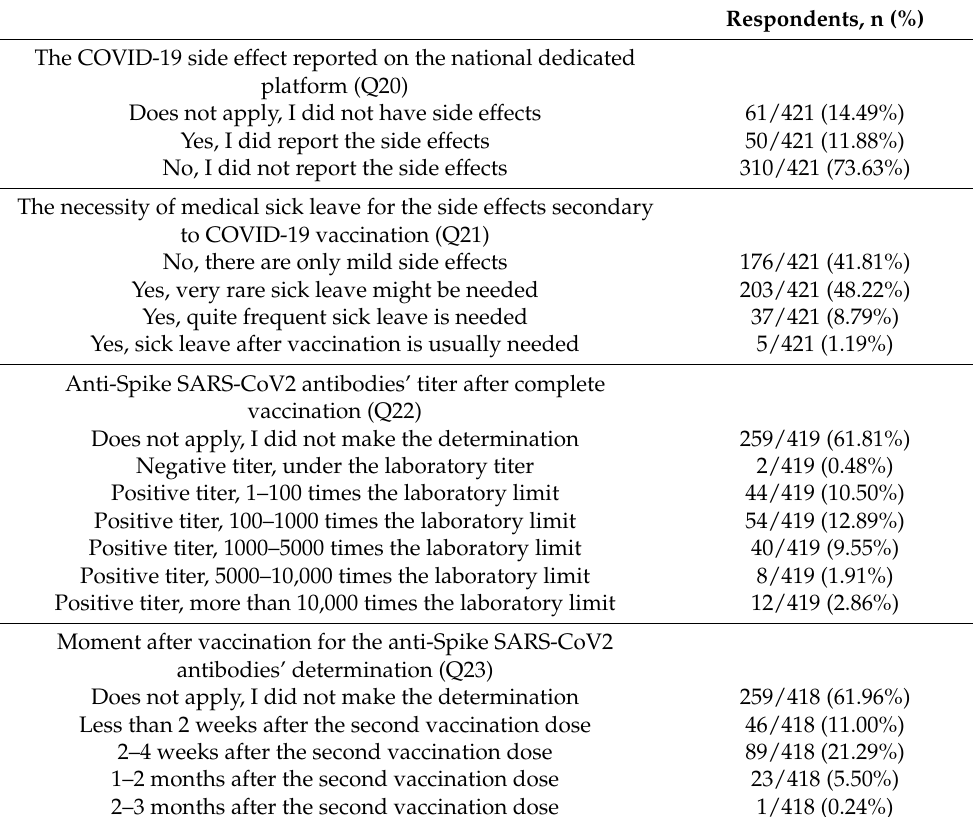
Table 3. Impact of the COVID-19